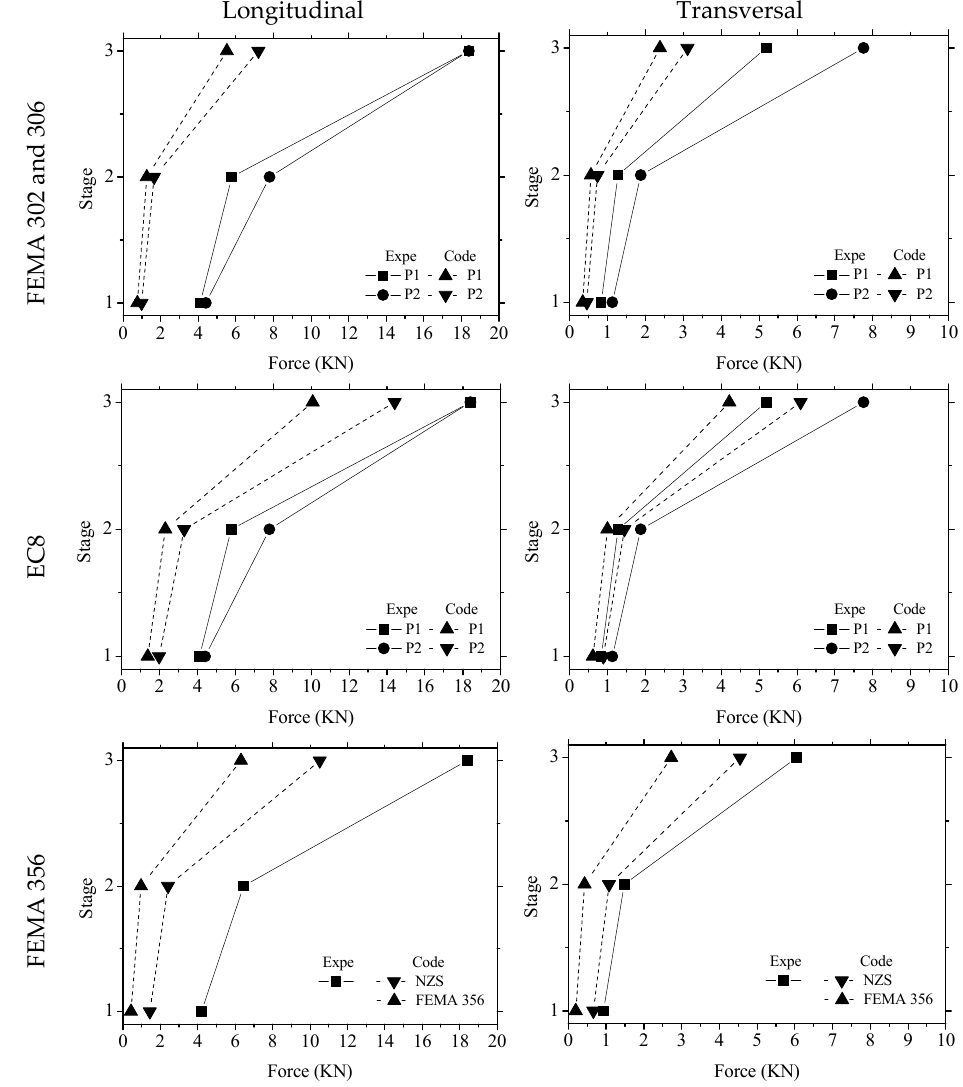
Figure 12. Standard and experimental out-of-plane load comparison for model 3.